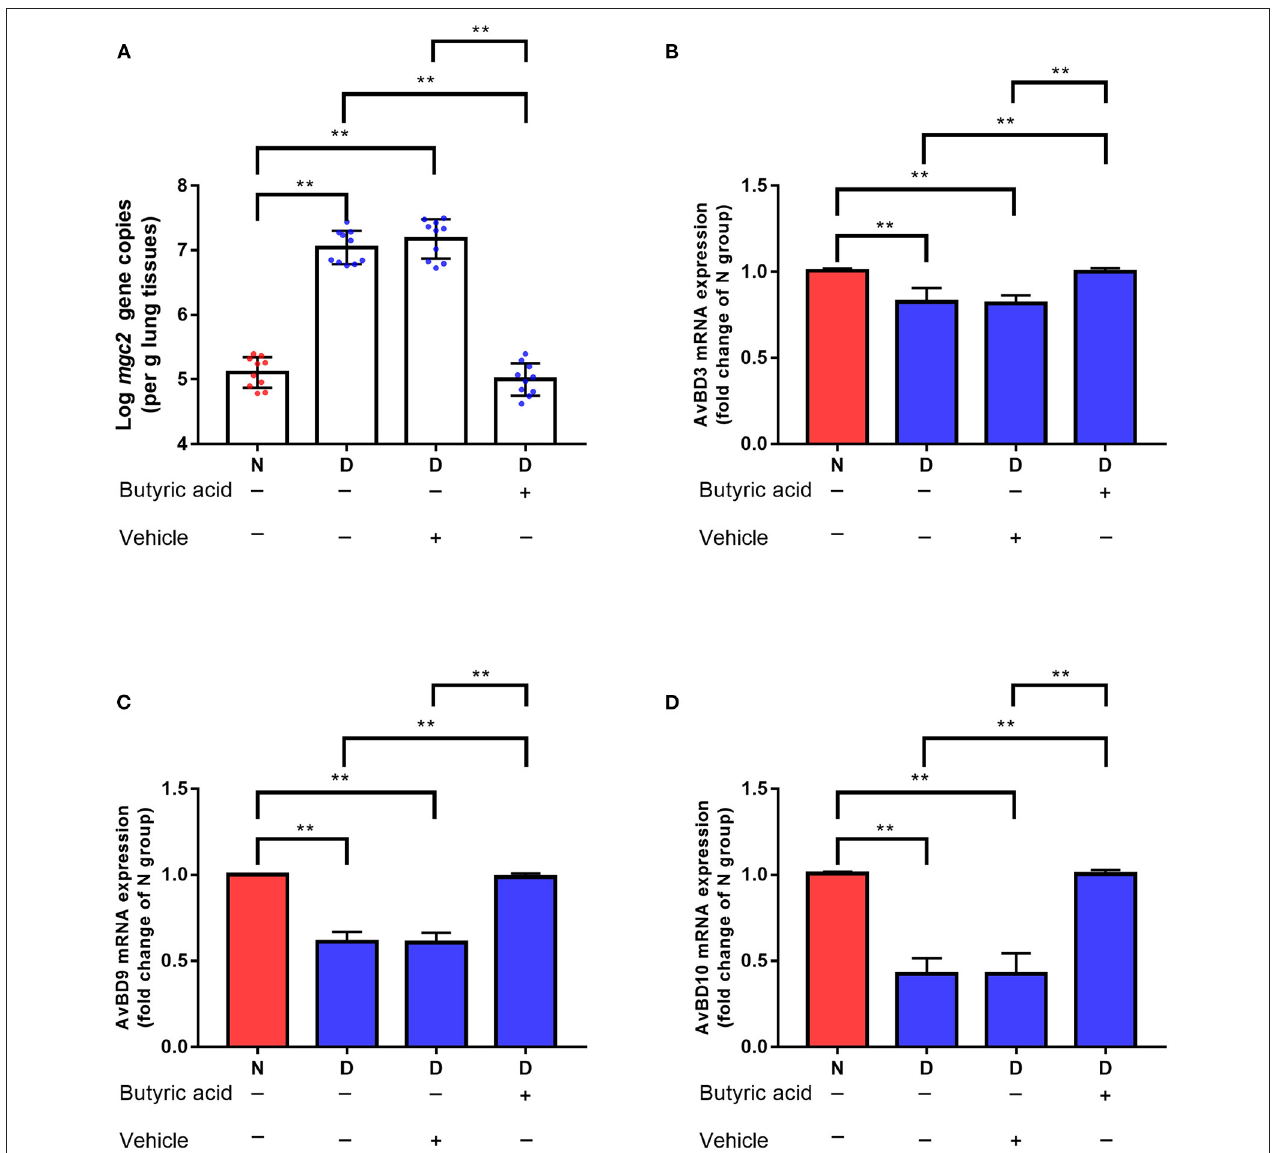
FIGURE 7 | Effects of butyric acid supplementation on MG colonization in lung of gut microbiota dysbiosis group. (A) Mgc2 gene copies in chicken lung after MG infection ( n = 10). (B) AvBD3 mRNA expression levels in chicken lung after MG infection ( n = 6). (C) AvBD9 mRNA expression levels in chicken lung after MG infection ( n = 6). (D) AvBD10 mRNA expression levels in chicken lung after MG infection ( n = 6). Indicated groups were orally administered sodium butyrate at 1 g/kg feed from day 48 to day 51 showed in Figure 1 . **Indicates P <